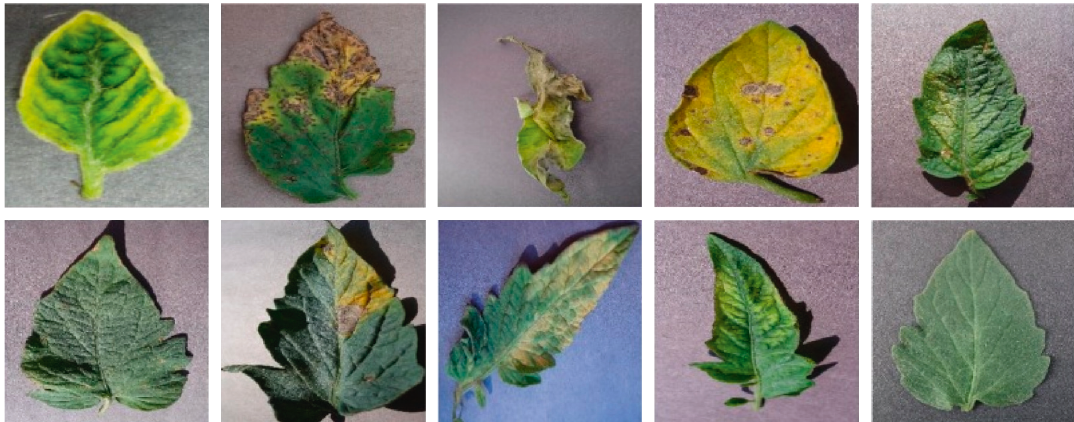
Figure 1: Sample images from PlantVillage database.